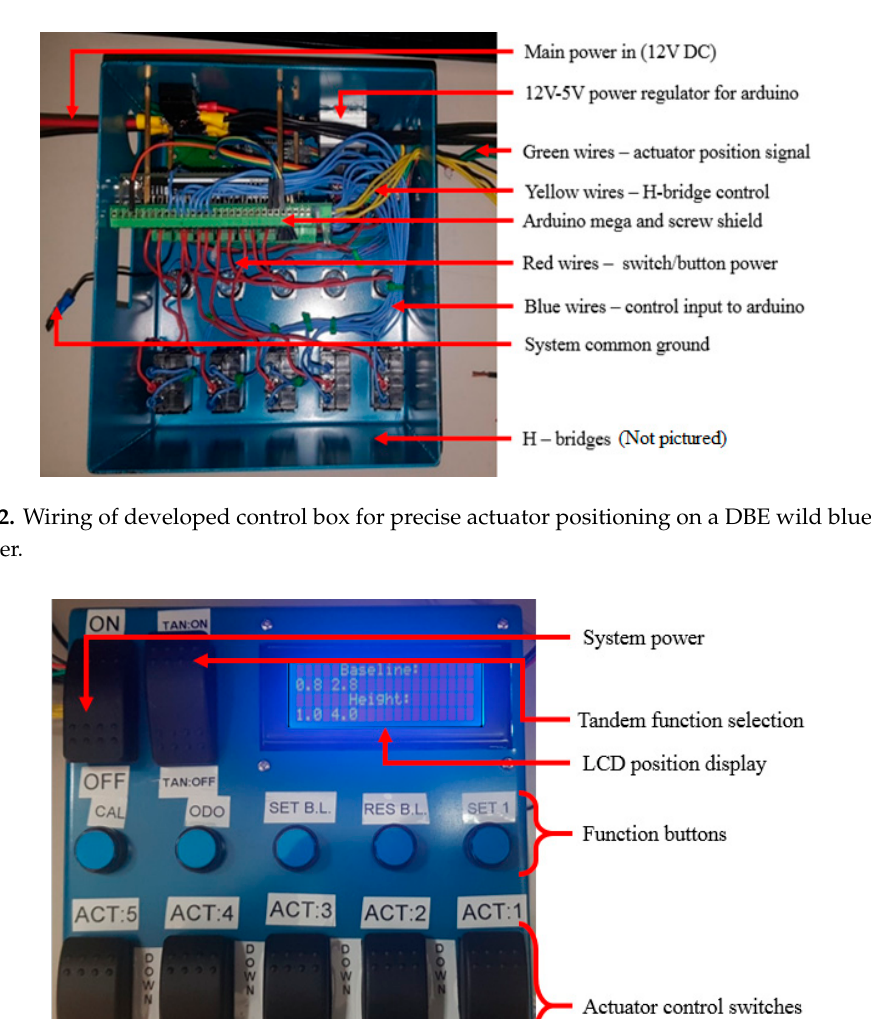
Figure 2. Wiring of developed control box for precise actuator positioning on a DBE wild blueberry harvester.